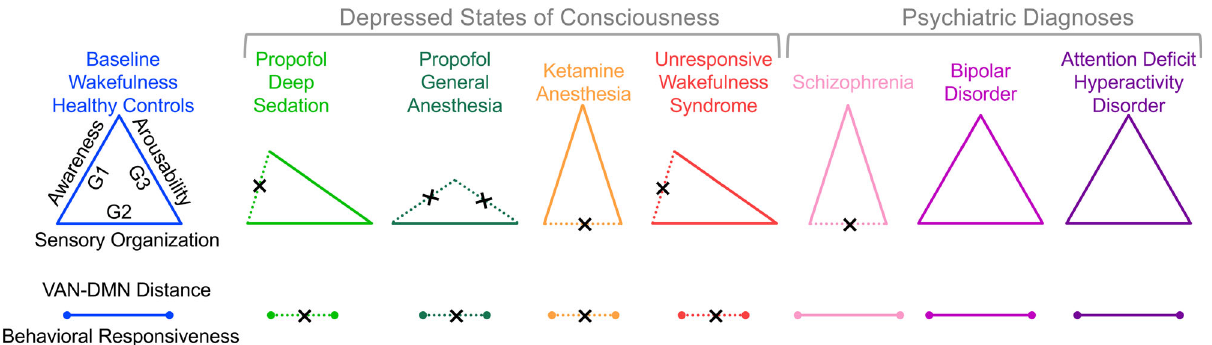
Fig. 7 | Schematic illustration of the common and speci fi c gradient features of various states of consciousness. The three cortical gradients (G1, G2, and G3) putatively represent three dimensions of consciousness, i.e., awareness, sensory organization, and arousability. Reduced network distance between ventral